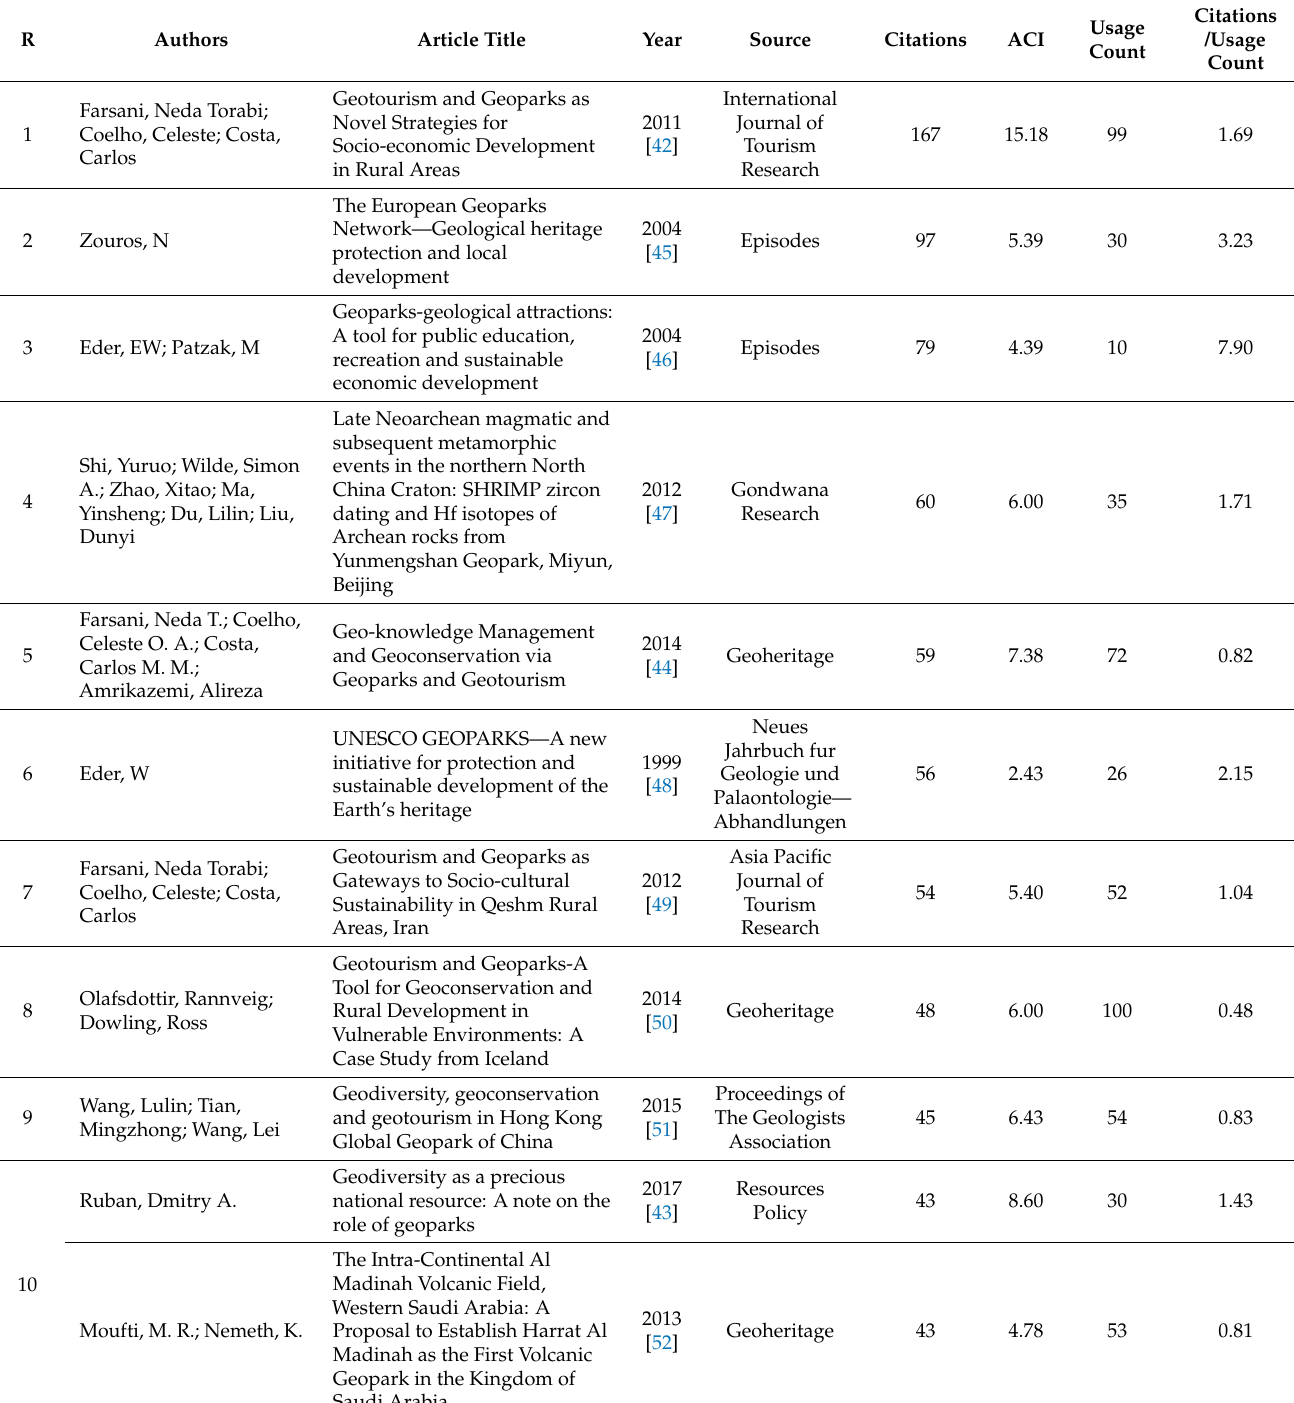
Table 2. Top 10 frequently cited documents during 1999–2022 on Geoparks in